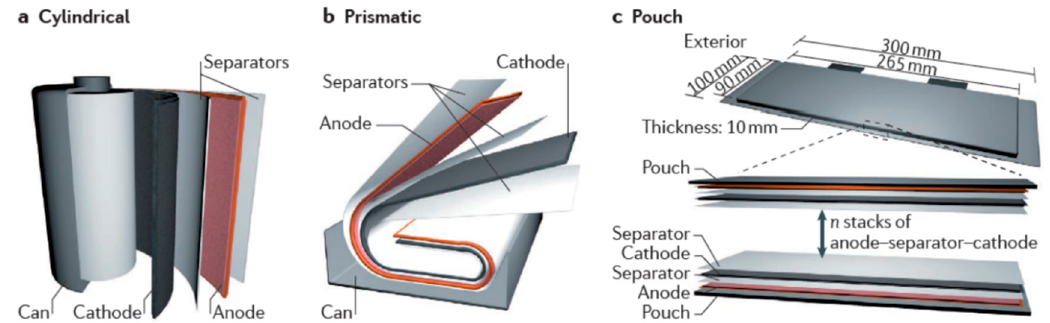
Figure 12. Schematic representation of cylindrical ( a ), prismatic ( b ), and pouch ( c ) cell configurations. Reproduced with permission from [108].